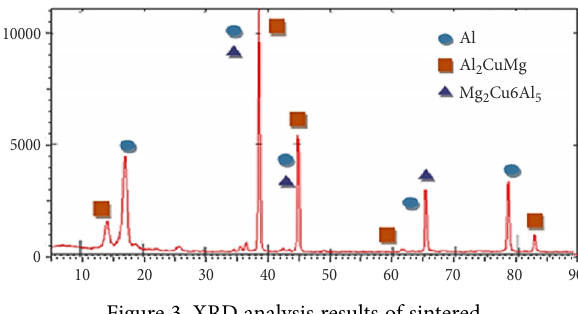
Figure 1. Electrochemical corrosion cell used in this study